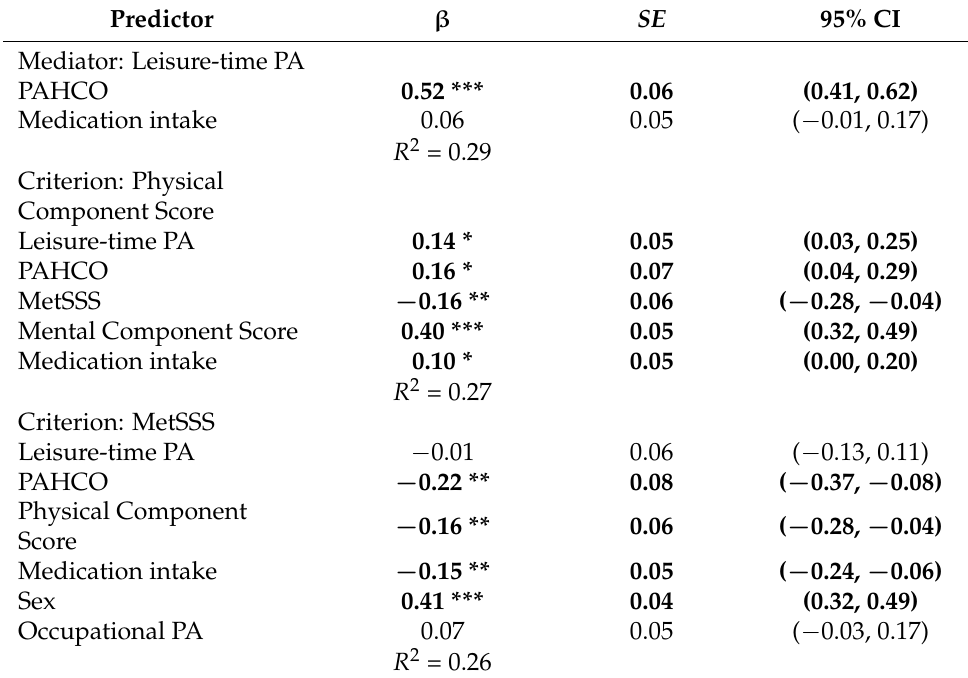
Table 3. Standardized path coefficients, SEs, and 95% CIs for the